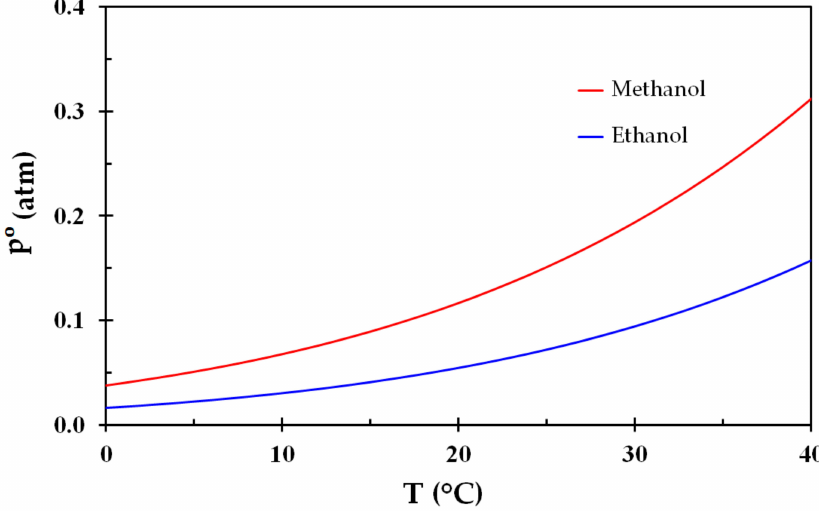
Figure 1. Vapor pressure of methanol and ethanol as a function of temperature (Equation